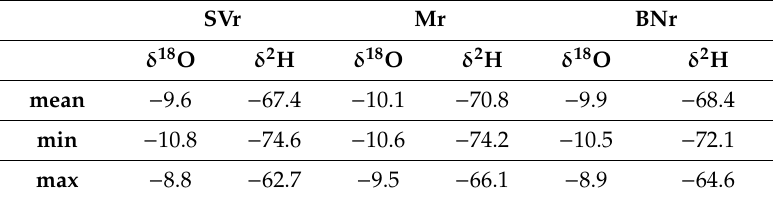
Table 3. The mean, maximum (max), and minimum (min) δ 18 O and δ 2 H values in river water at Suceava (SVr), Moldova (Mr) and Bistrita (BNr) river stations. SVr